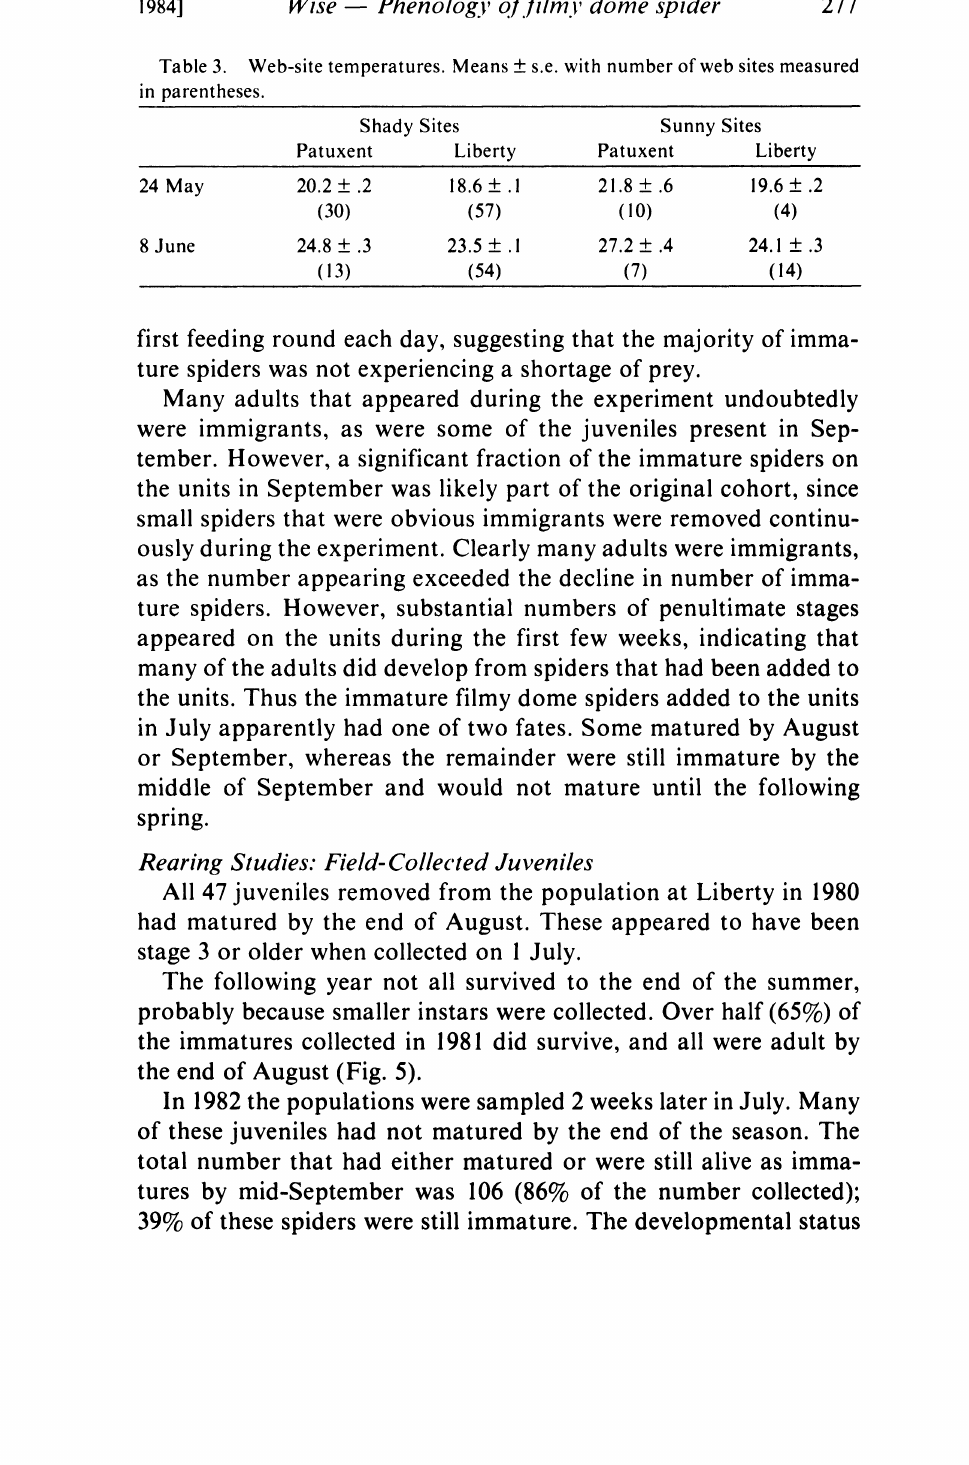
Table 3. Web-site temperatures. Means _+ s.e. with number of web sites measured in